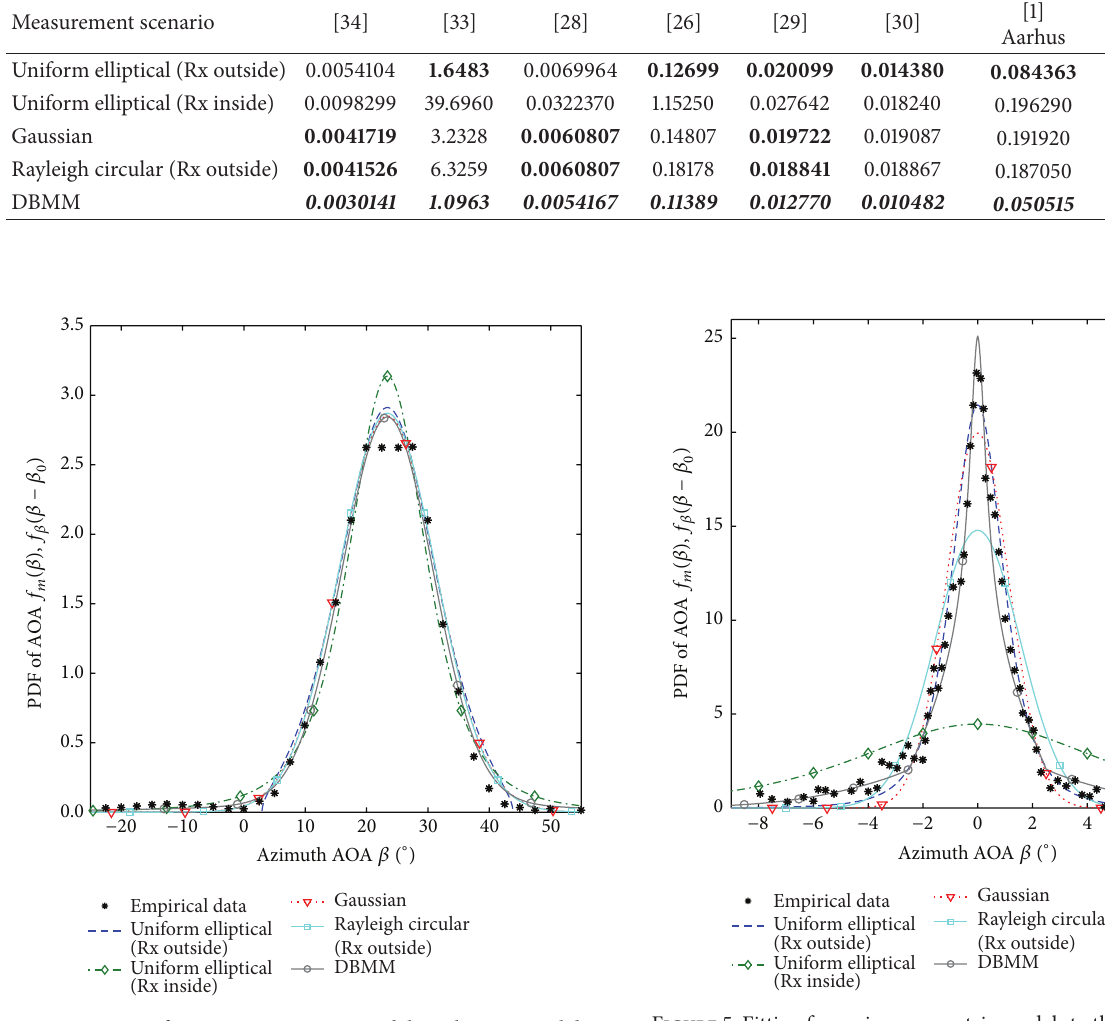
Figure 4: Fitting for various geometric models to the empirical data in Matthews et al. [34, Figure 7 ].